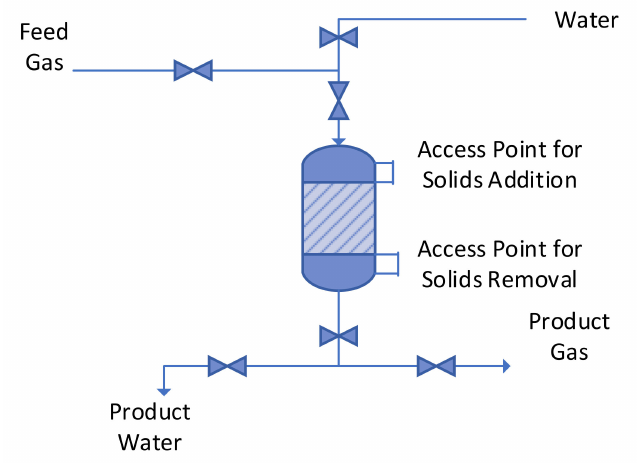
Figure 4. Halite Reactor showing access points for solids addition and removal, and access points for water used to wash and clean the